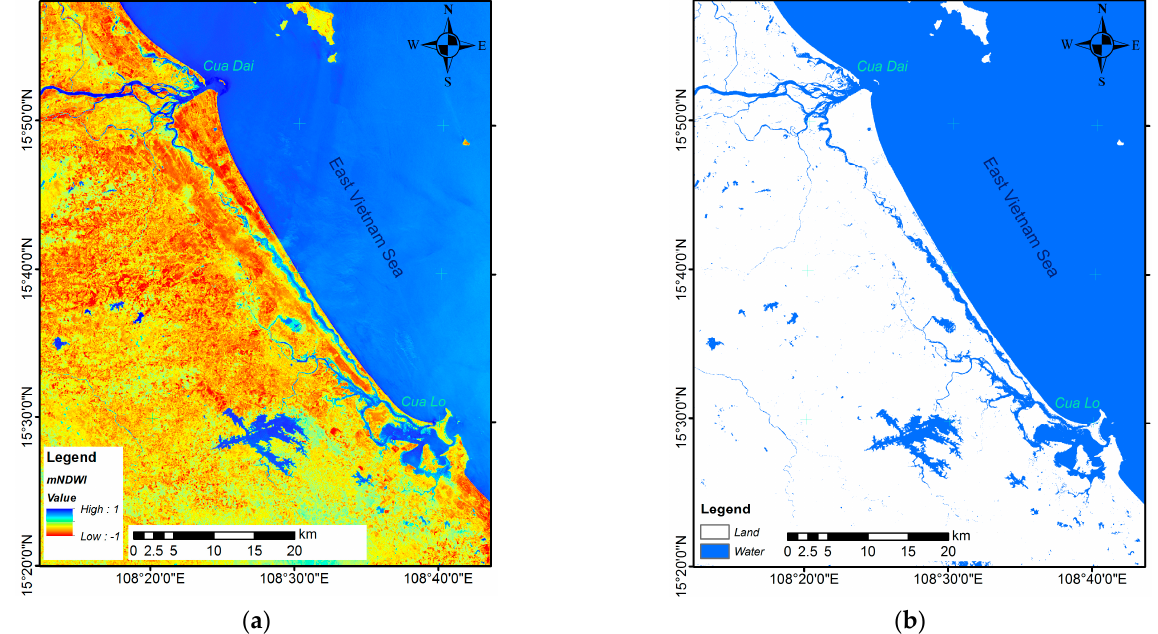
Figure 6. ( a ) An example of the mNDWI map and ( b ) land–water classification map of Quang Nam province on 4 July, 2019.